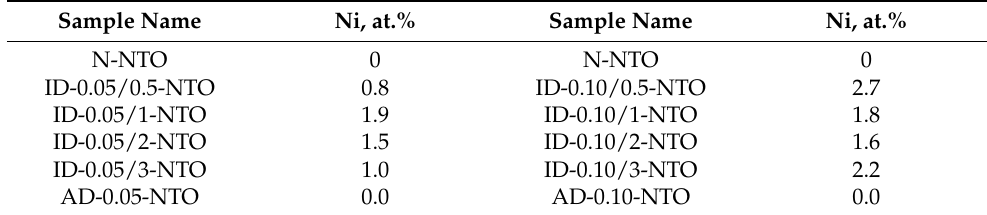
Table 1. Composition of the samples studied in the work.